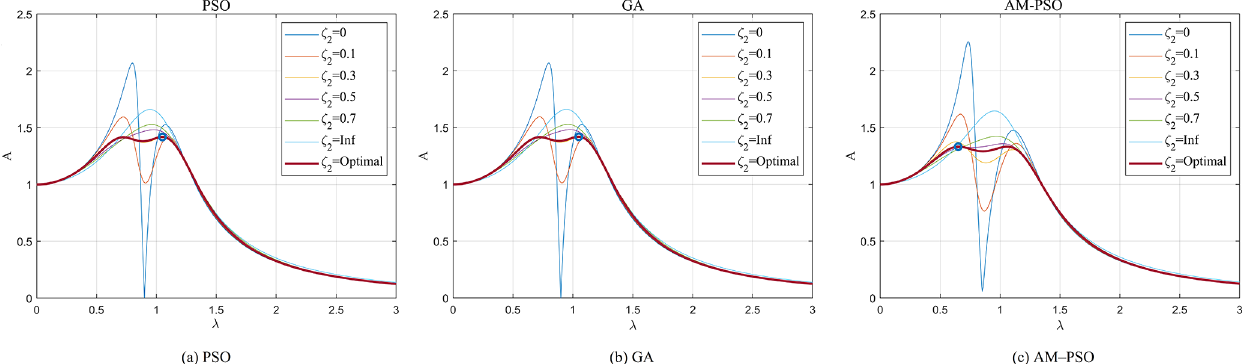
Figure 7. Influence of tuning parameter ζ 2 on the three-element DVA under different optimization algorithms.